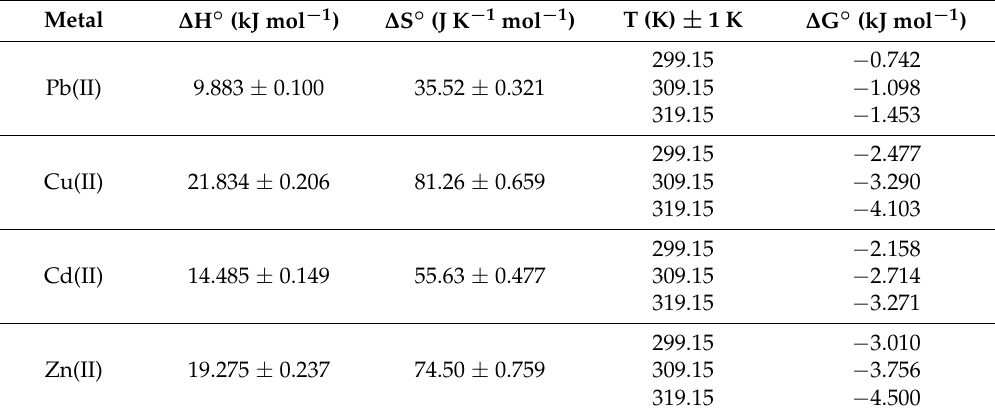
Table 4. Adsorption isotherm parameters of metal ions onto SiTF 5 PP .